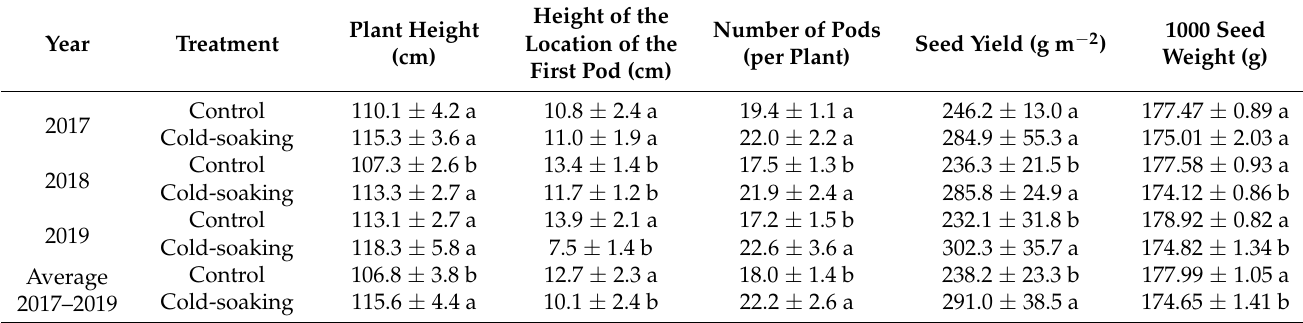
Table 4. Effect of treatment with L. usitatissimum water extract on biometric traits and yield of soybean (average ± SD).